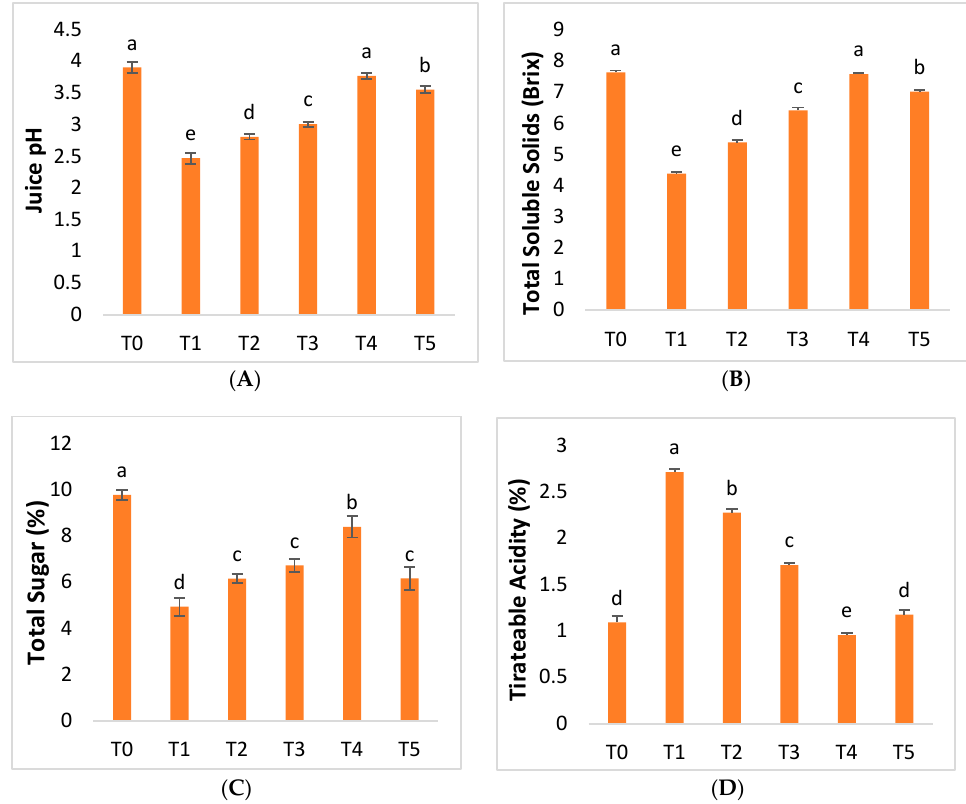
Figure 9. Differential effects of AgNP treatments on ( A ) juice pH, ( B ) total soluble solids, ( C ) total sugar, and ( D ) titratable acidity (TA).